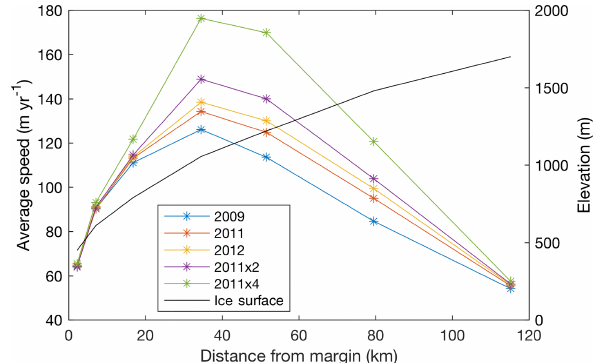
Figure 10. Averaged modelled melt season velocities at each of the GPS sites for the different years and future melt scenarios. Ice sur- face elevation also shown.